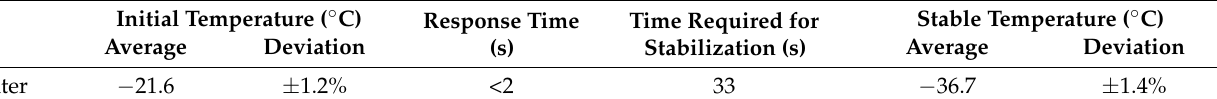
Table 7. Experimental data of three stages under the heat flux of 850 W/m 2 .